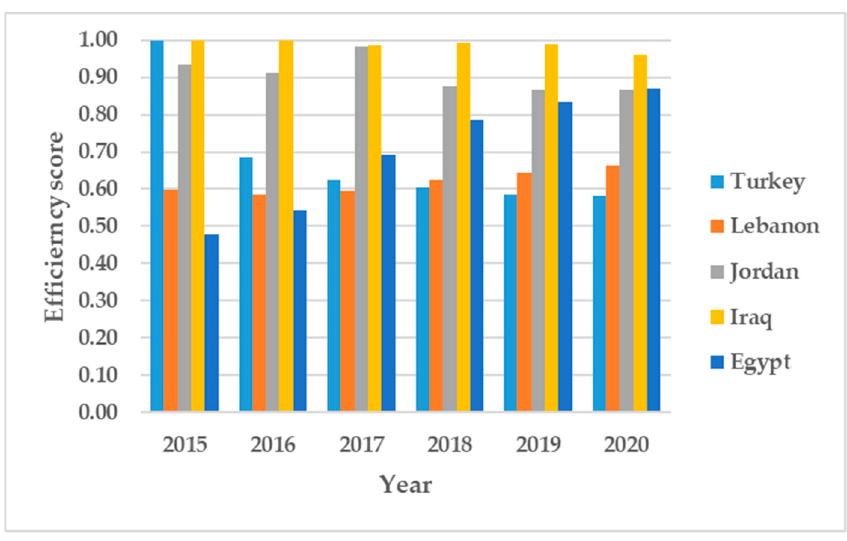
Figure 4. Scale efficiency scores.